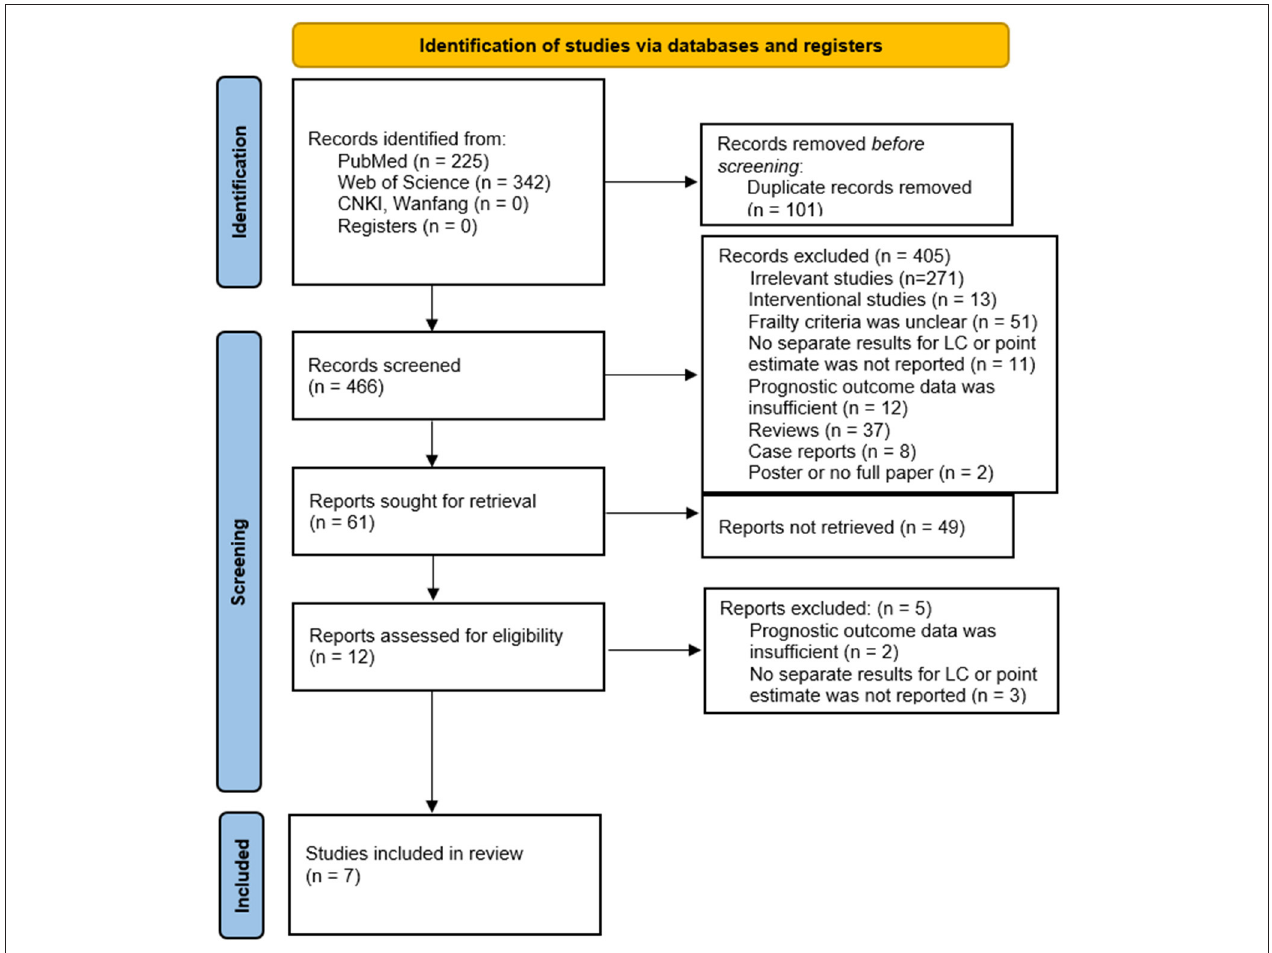
FIGURE 1 | The PRISMA diagram for study selection. PRISMA: preferred reporting items for systematic reviews and meta-analyses. From